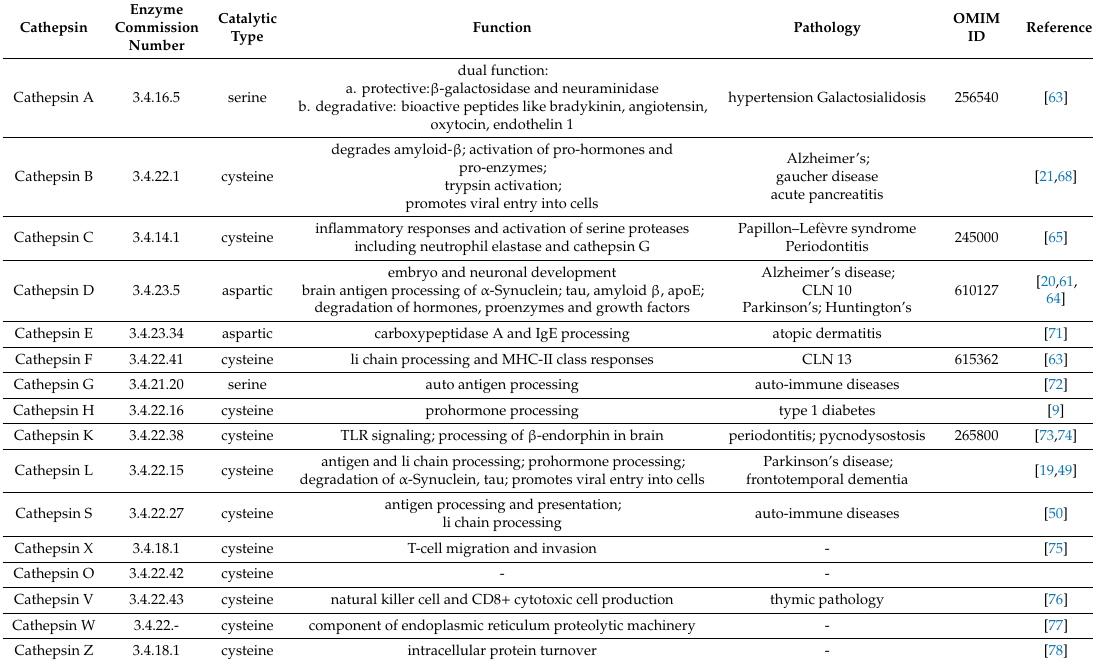
Table 1. Cathepsins in the endo / lysosomal